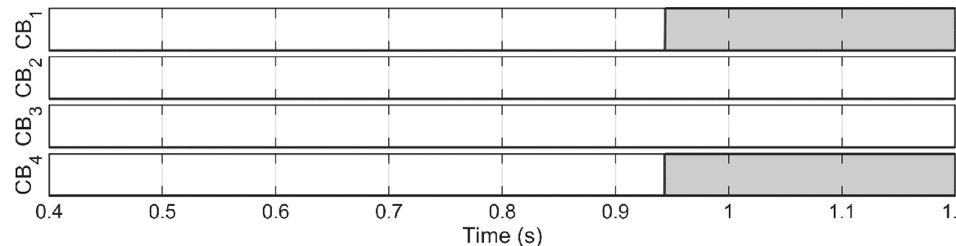
Figure 24. Relay trip signals in case DCR and DOCR fail: ( a ) relays in HTS 1 ; ( b ) relays in HTS 2 .